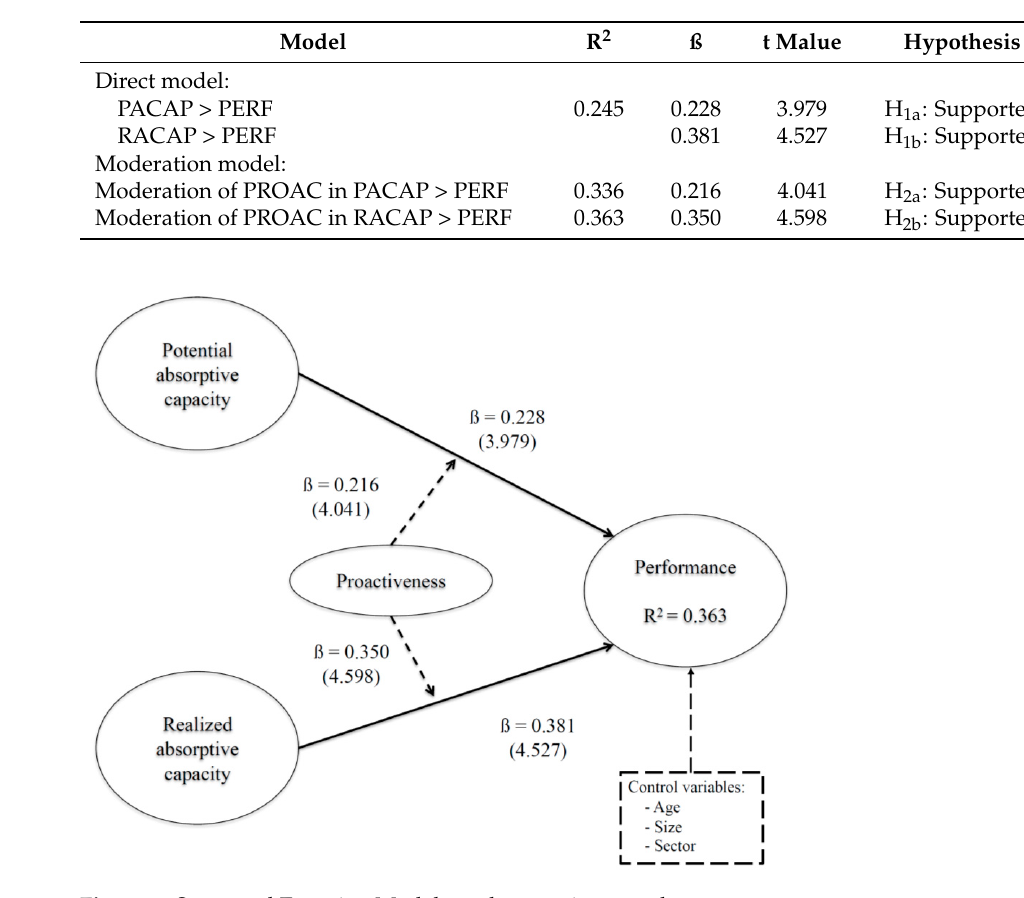
Figure 2. Structural Equation Model. t values are in parentheses. Table 6. Structural model.